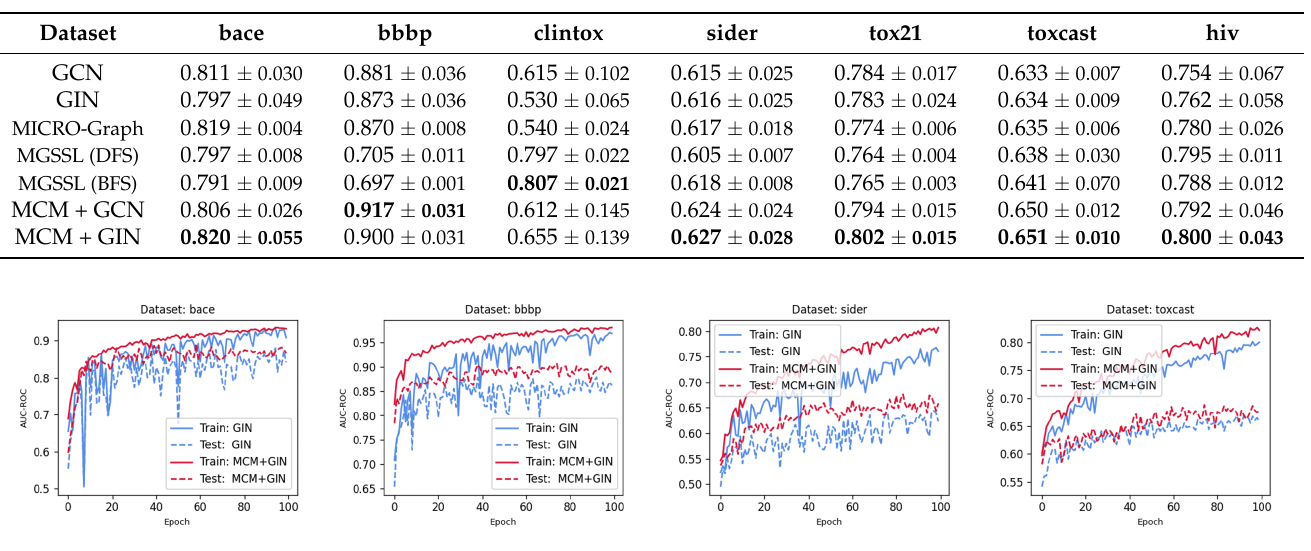
Table 2. Compare test ROC-AUC (mean ± std) on molecular property prediction benchmarks. The best result for each dataset is in bold.